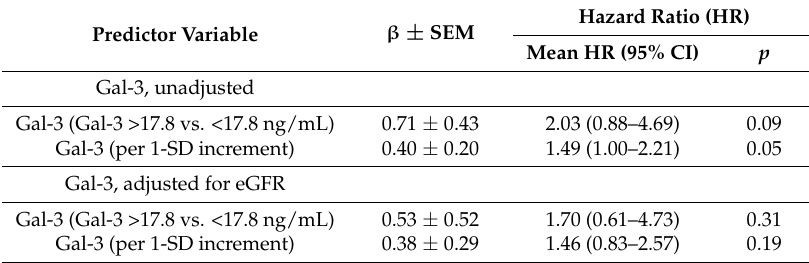
Table 5. Cox proportional hazards regression of all-cause mortality on baseline galectin-3 (Gal-3) levels for all AS patients irrespective of type of treatment